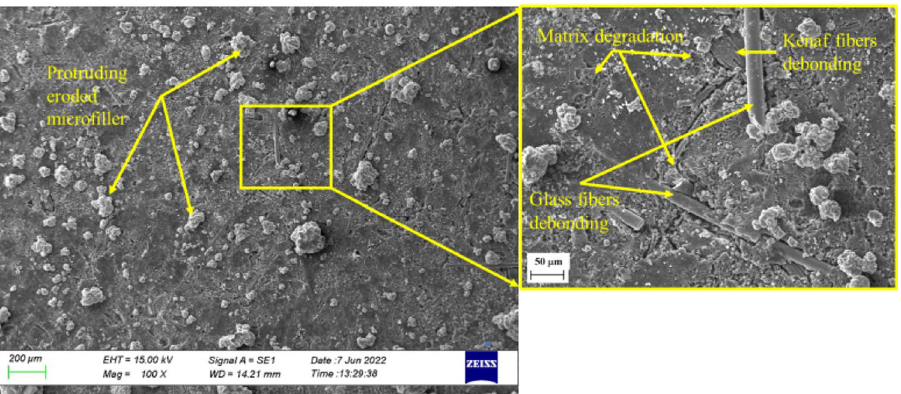
Figure 15. Scanning electron micrographs of the surface of the MCC12 composite post-immersion in the acidic solution.